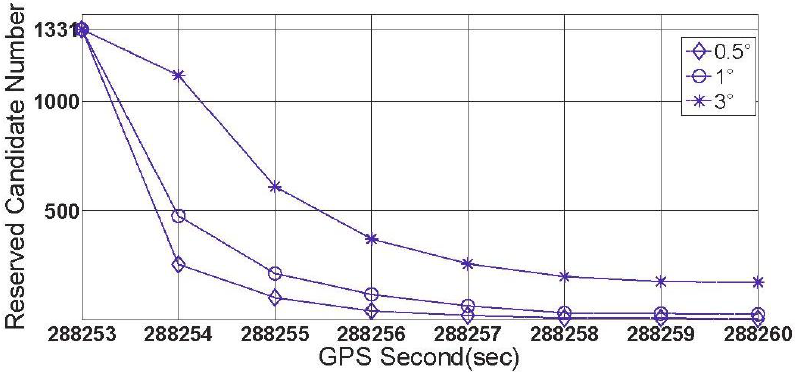
Figure 13. The second group of the results for the feasibility test (data section C).